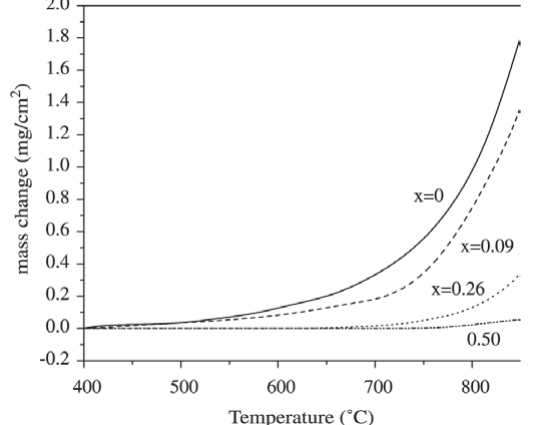
Figure 4. SEM topographies of coatings (Ti